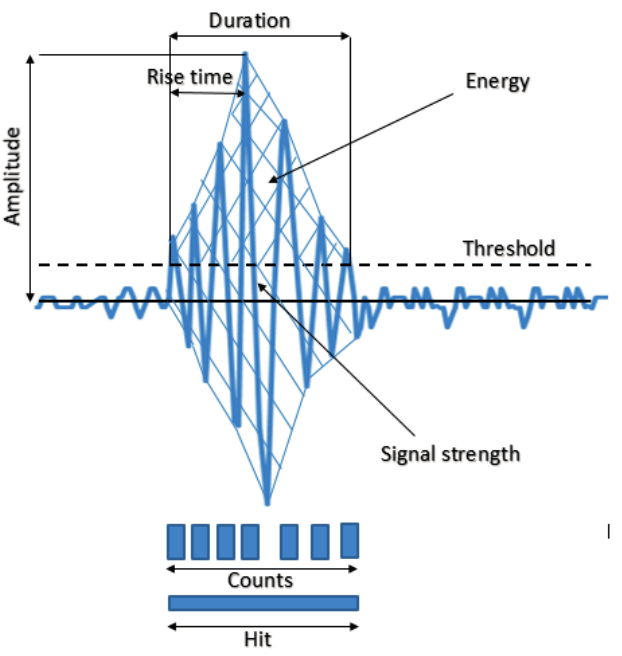
Figure 4. Parameters reflecting of an AE